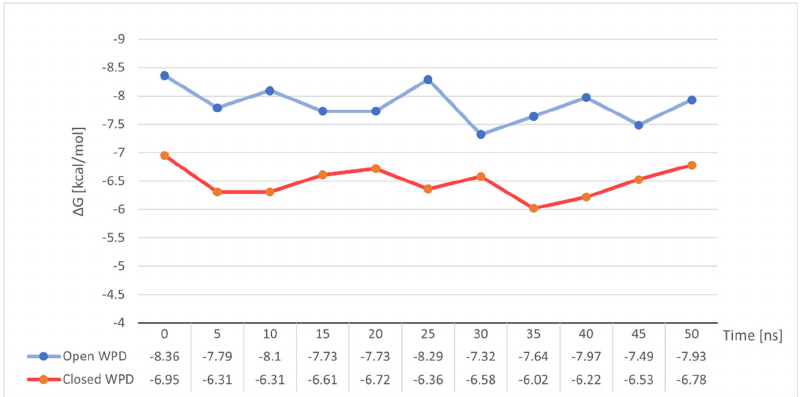
Figure 12. Changes in binding free energy for Compound 4 during MD simulation measured at 5ns intervals.